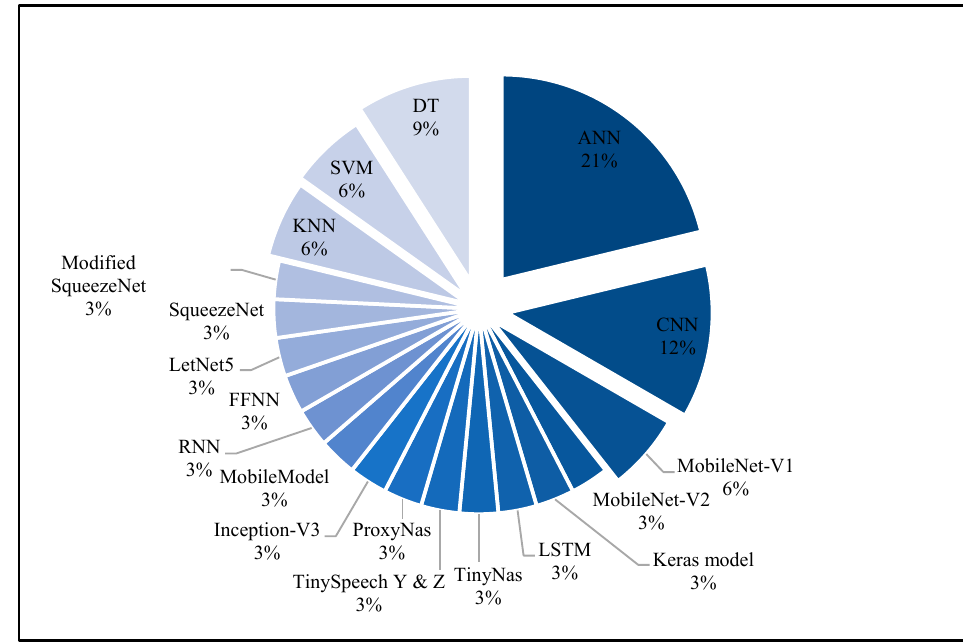
Figure 5. Machine and deep-learning models distributed in previous studies.